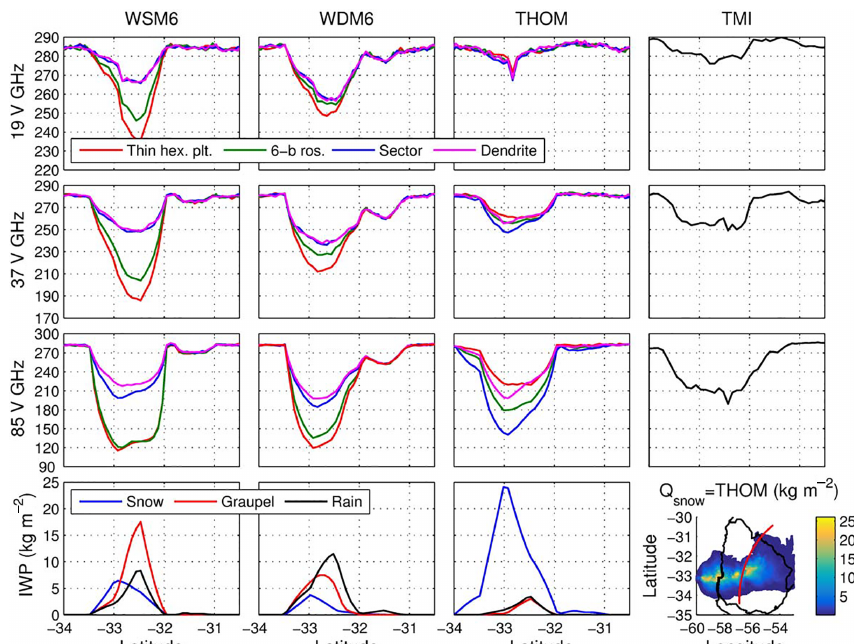
Figure 8. The simulated brightness temperatures for the TMI 19V, 37V, 85VGHz channels along a specific transect of interest shown in the bottom right panel, using selected Liu (2008) DDA habits (see legend) and the WSM6, WDM6 and THOM WRF schemes (the first three columns) and the observed brightness temperatures (in black in the last column). The corresponding integrated mass content of snow, graupel and rain are shown in the bottom row. Note that the bottom right panel shows the column-integrated WRF(THOM) snow mass content for the whole scene together with a solid red line to illustrate the location of the transect of